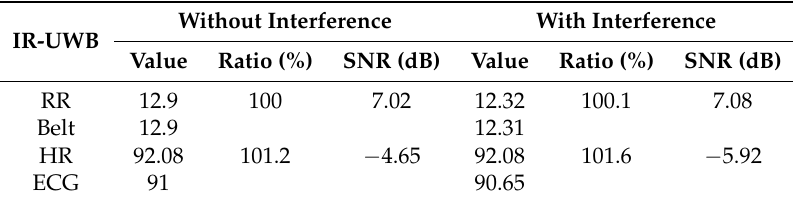
Table 12. Anti-interference results of IR-UWB